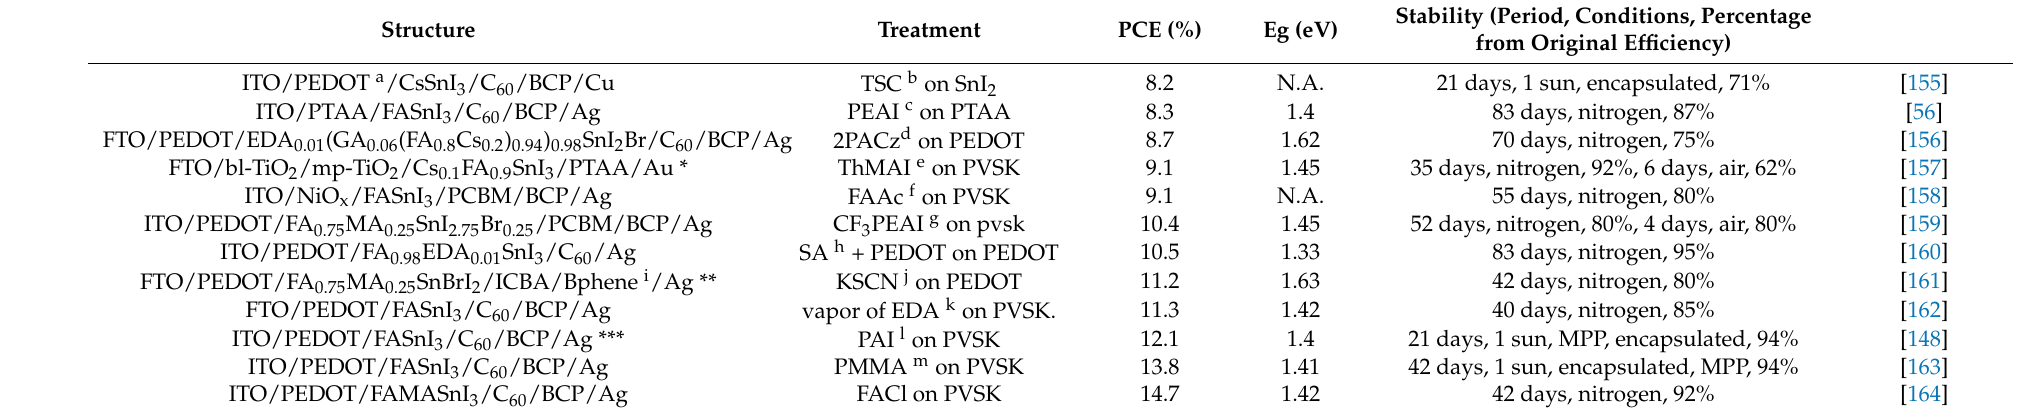
Table 2. Surface and Pb-free. Best-performing Pb-free TPSCs with perovskite surface/interface modifiers reported in 2021 and 2022.